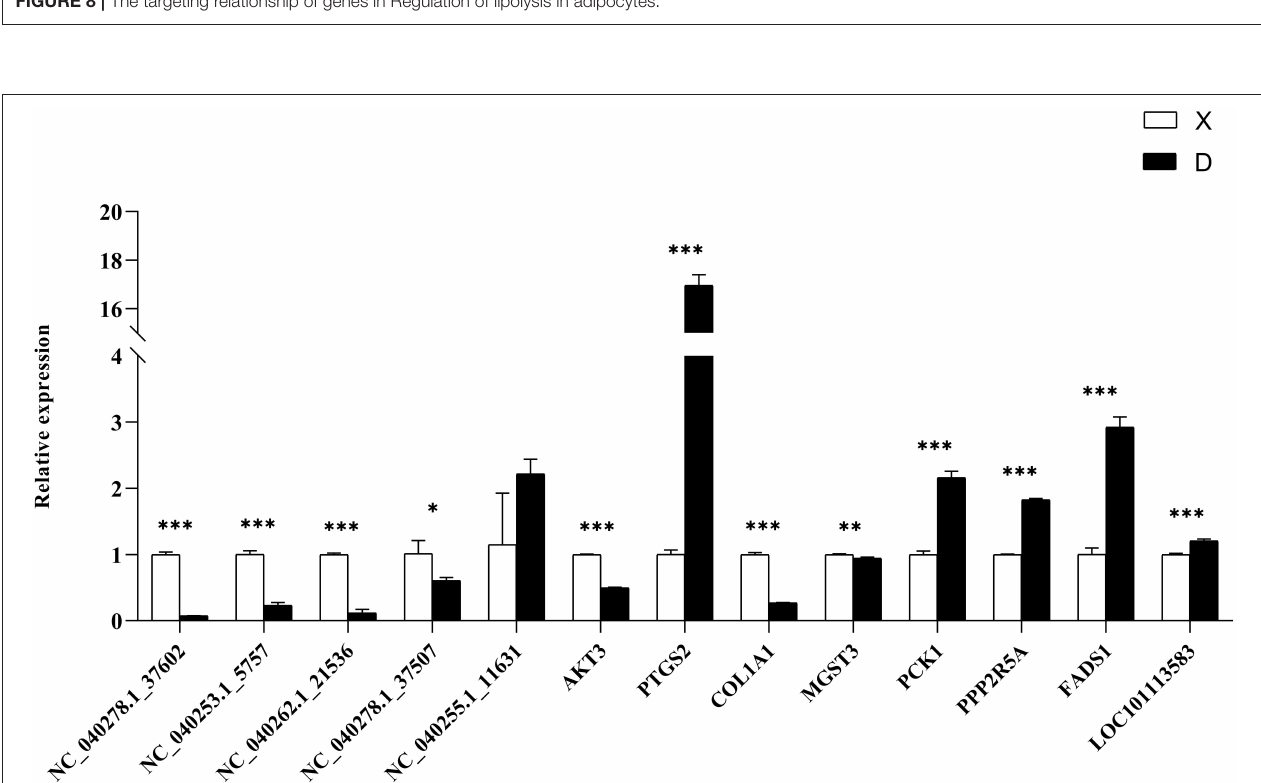
FIGURE 9 | qRT-PCR verification of differentially expressed genes. The differential expression of genes in subcutaneous adipose tissues between Duolang and Small Tail Han sheep was verified qRT-PCR. * P < 0.05; ** P < 0.01; *** P <